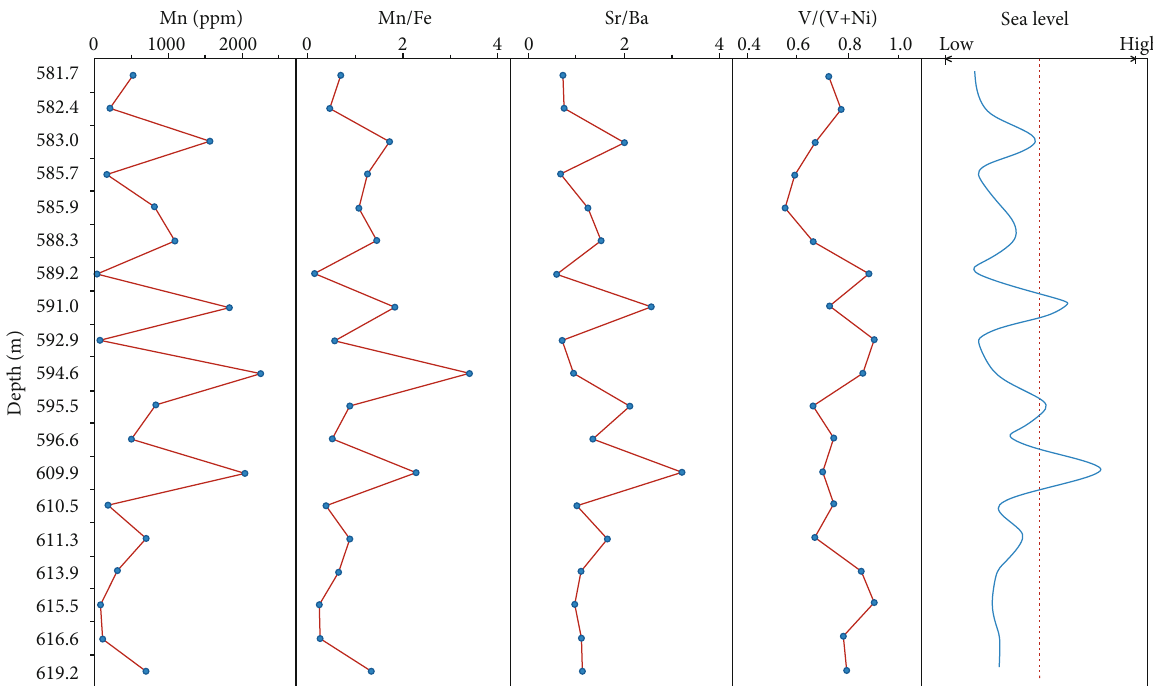
Figure 3: Trace element geochemical analysis test of the Lopingian paleooxygen phase of the borehole